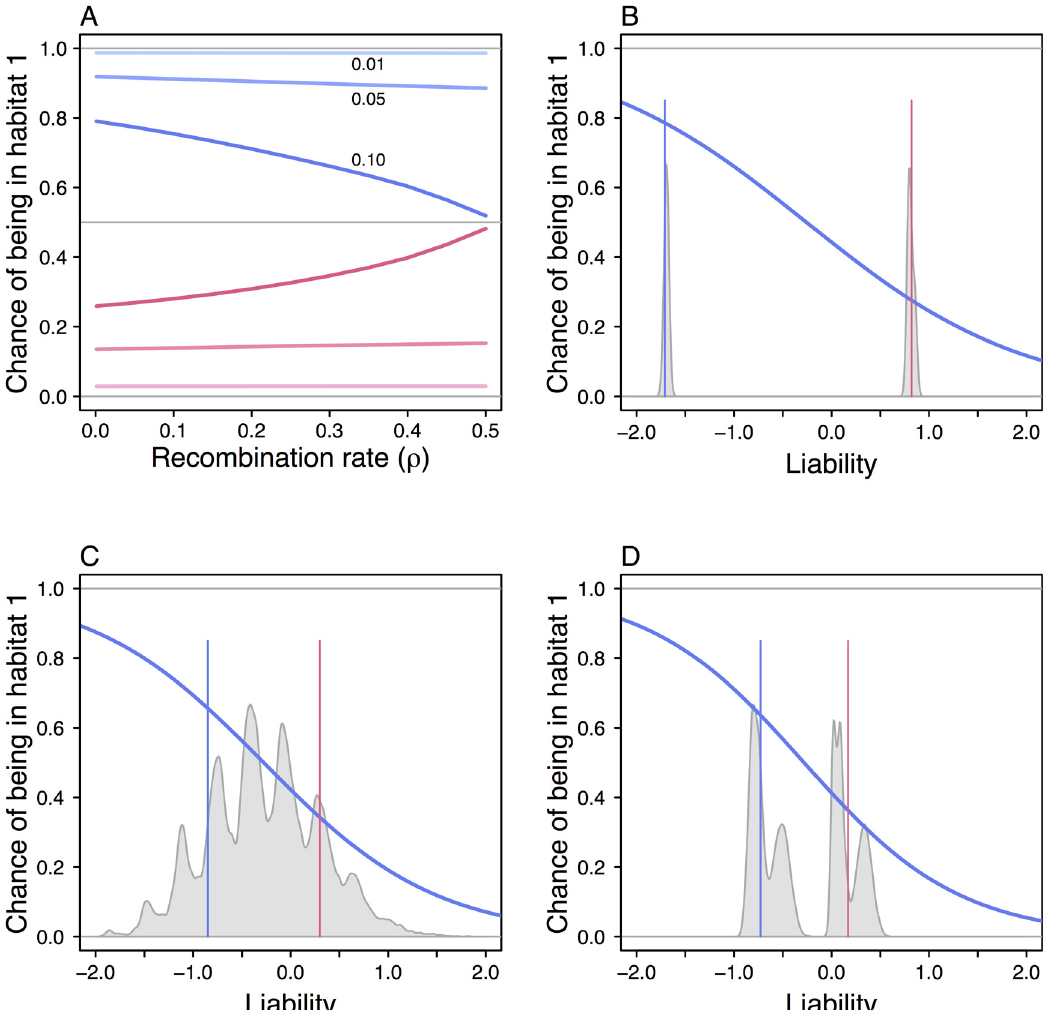
The probability is given as a function of the recombination rate ρ between cue and modifier loci. The three cases are from Fig 2, with different rates of between-habitat migration m 12 = m 21 = m = 0.01, 0.05, 0.10. The blue lines in panels (B) to